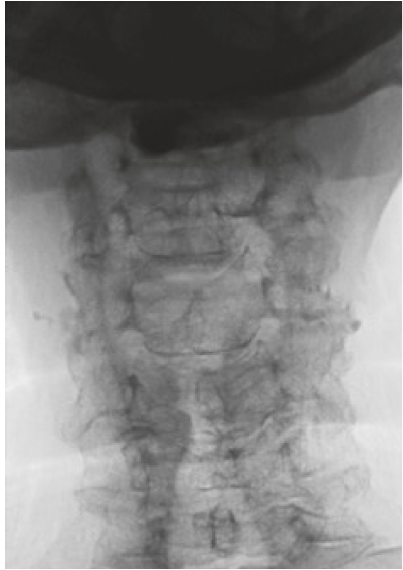
Figure 2: AP view with black/white